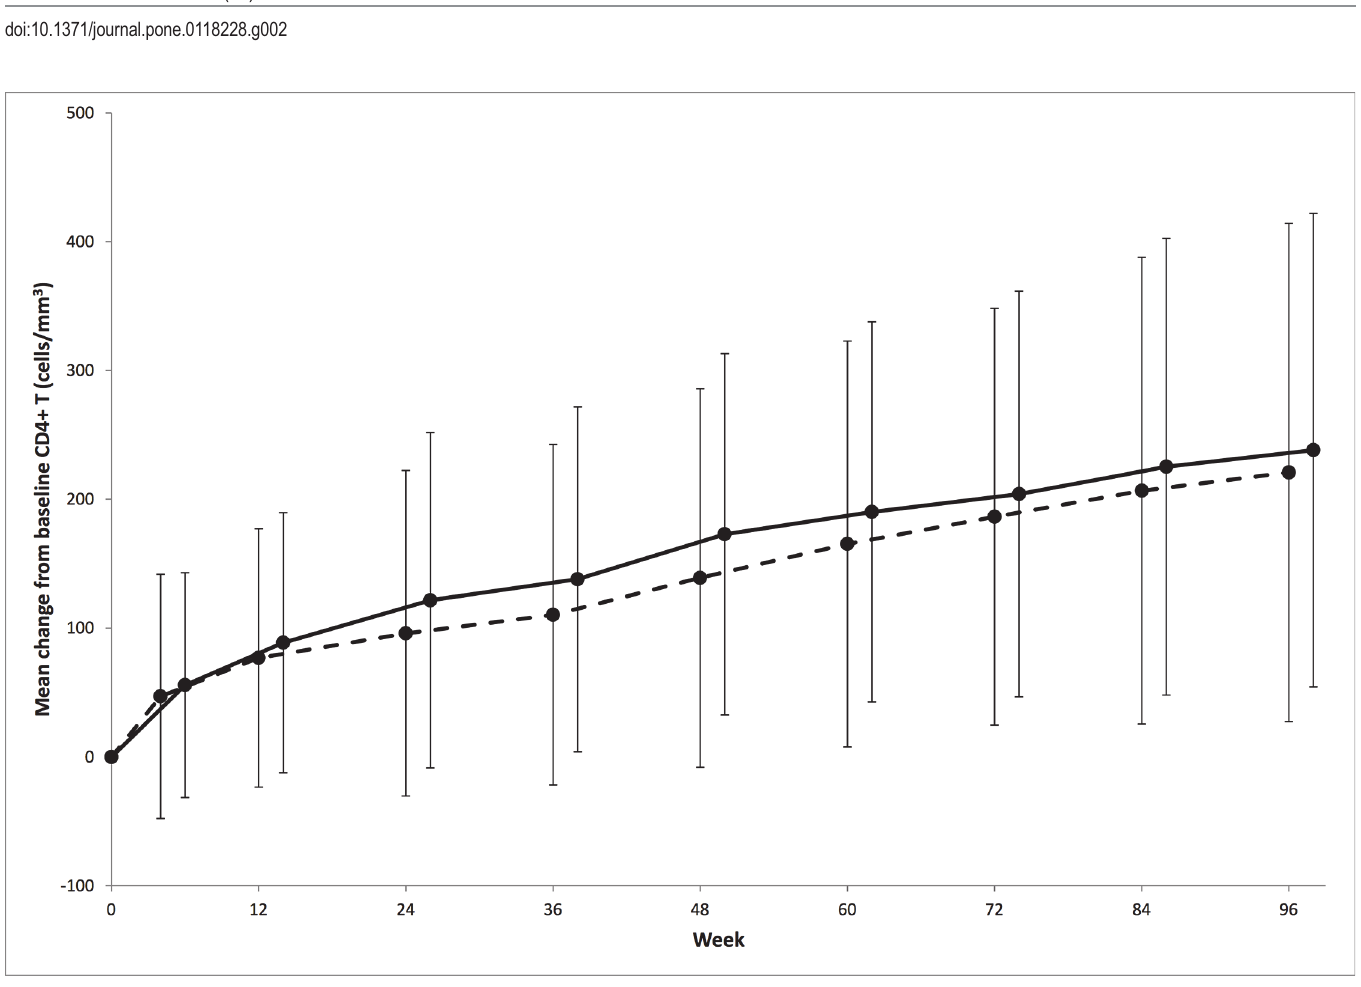
Fig 3. Mean change from baseline in CD4+ T cells/mm 3 over 96 weeks by randomised arm. RAL = lopinavir/ritonavir+raltegravir Control = lopinavir/ ritonavir+2/3 nucleoside/nucleotide reverse transcriptase inhibitors. (Control- - - RAL — , bars indicate standard deviation).